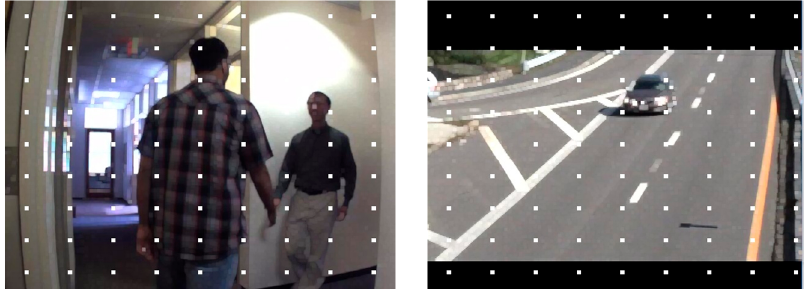
Figure 7. Outdoor scene results at 0.1 pixels, using the ( a ) SURF; ( b ) SIFT; and ( c ) Orb algorithms.